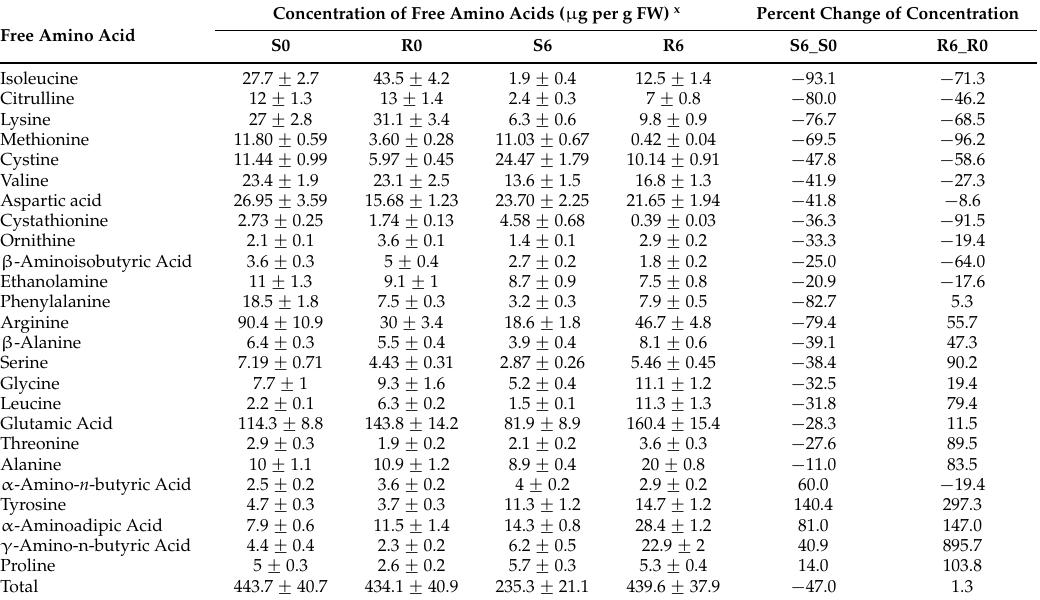
Table 4. The concentrations of free amino acids in the resistant (R) and susceptible (S) rice plants before (0 h) and after (6 h) attack by SBPH.